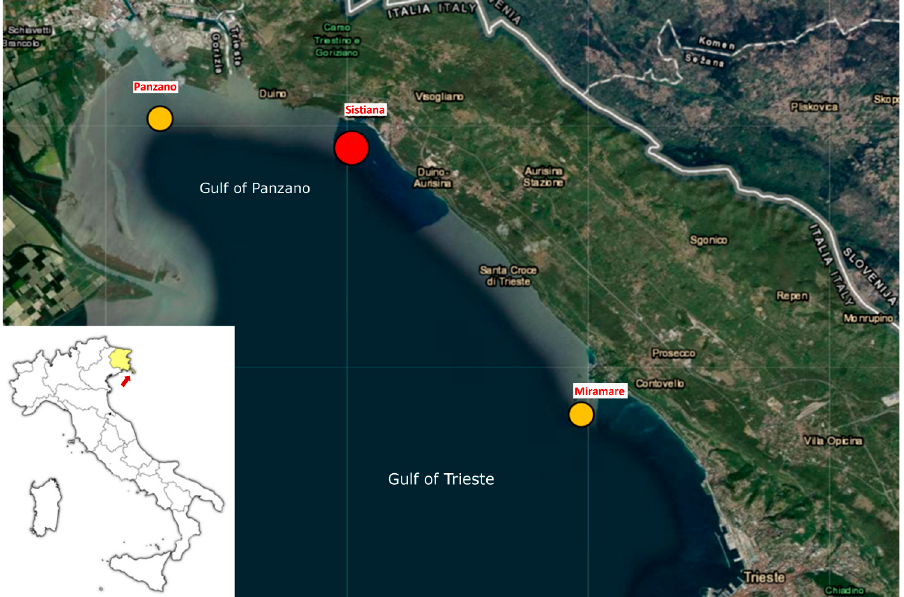
Figure 1. Map of Friuli Venezia Giulia region (a yellow region in figure Italy, the red arrow indicates monitored coast) showing stations where faecal and pseudofecal samples of P. nobilis were collected. In the samples collected in Panzano and Miramare, no H. pinnae DNA was detectable (sites indicated as yellow spot), while in Sistiana a positive result was obtained (shown as red spot). Table 1. Details of samples collected in the Gulf of Trieste alongside the date, collection place, and geographic coordinates.